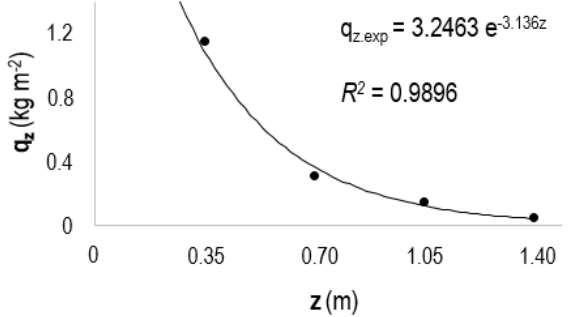
Figure 5. Example of estimated sediment fluxes.